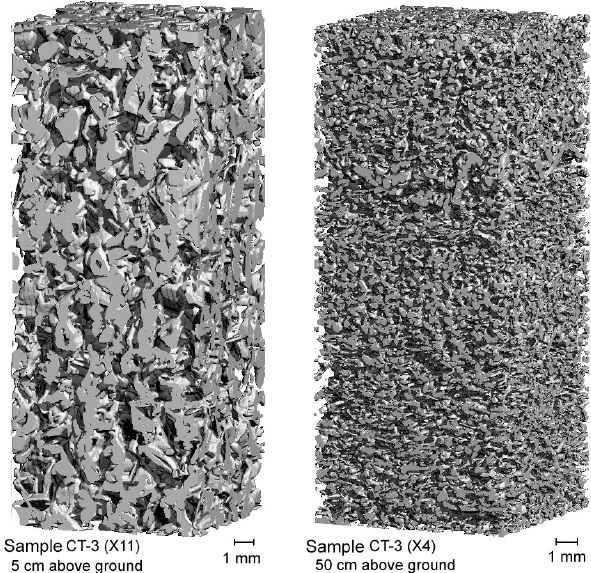
Figure 15. Two samples from the profile CT-3 (1 March 2012). The left profile, taken 5cm above ground, shows old metamorphic snow (depth hoar) with vertical structures ( A CT avg =− 0.24). The profile on the right, taken 50cm above ground, shows horizontal structures ( A CT avg =+ 0.35) of fresh, settled snow which fell 2 weeks before the sample was taken. The vertically resolved anisotropy, A CT , deter- mined every 2–5mm depth by means of µ CT, is plotted in Fig. 16c for both samples as blue